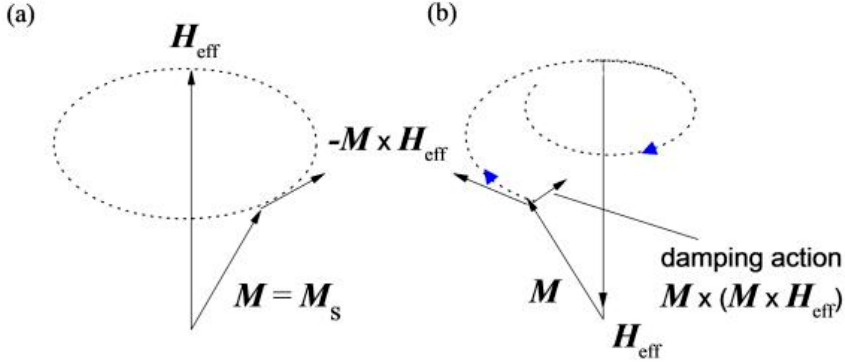
Figure 1. Dynamics of the magnetic moment M in the absence of dissipation losses ( a ) and with damping action ( b ) within the scheme of the Landau-Lifshitz equation. The blue arrow notifies the direction of moment trajectory.